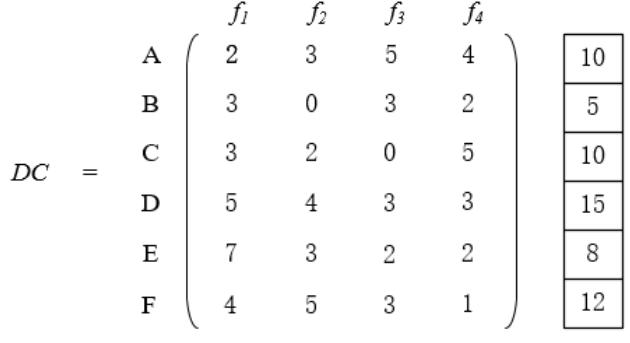
Figure 3. Deployment cost matrix.